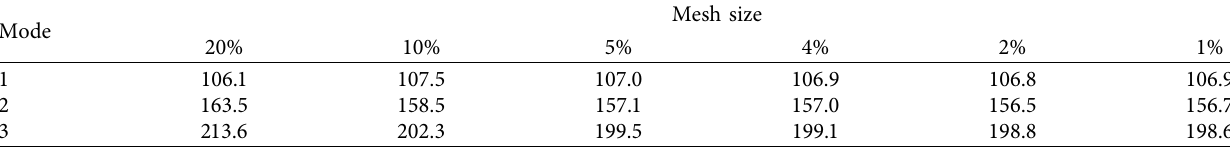
Table 1: Variations of natural frequencies (Hz) according to the mesh sizes of the intact plate.